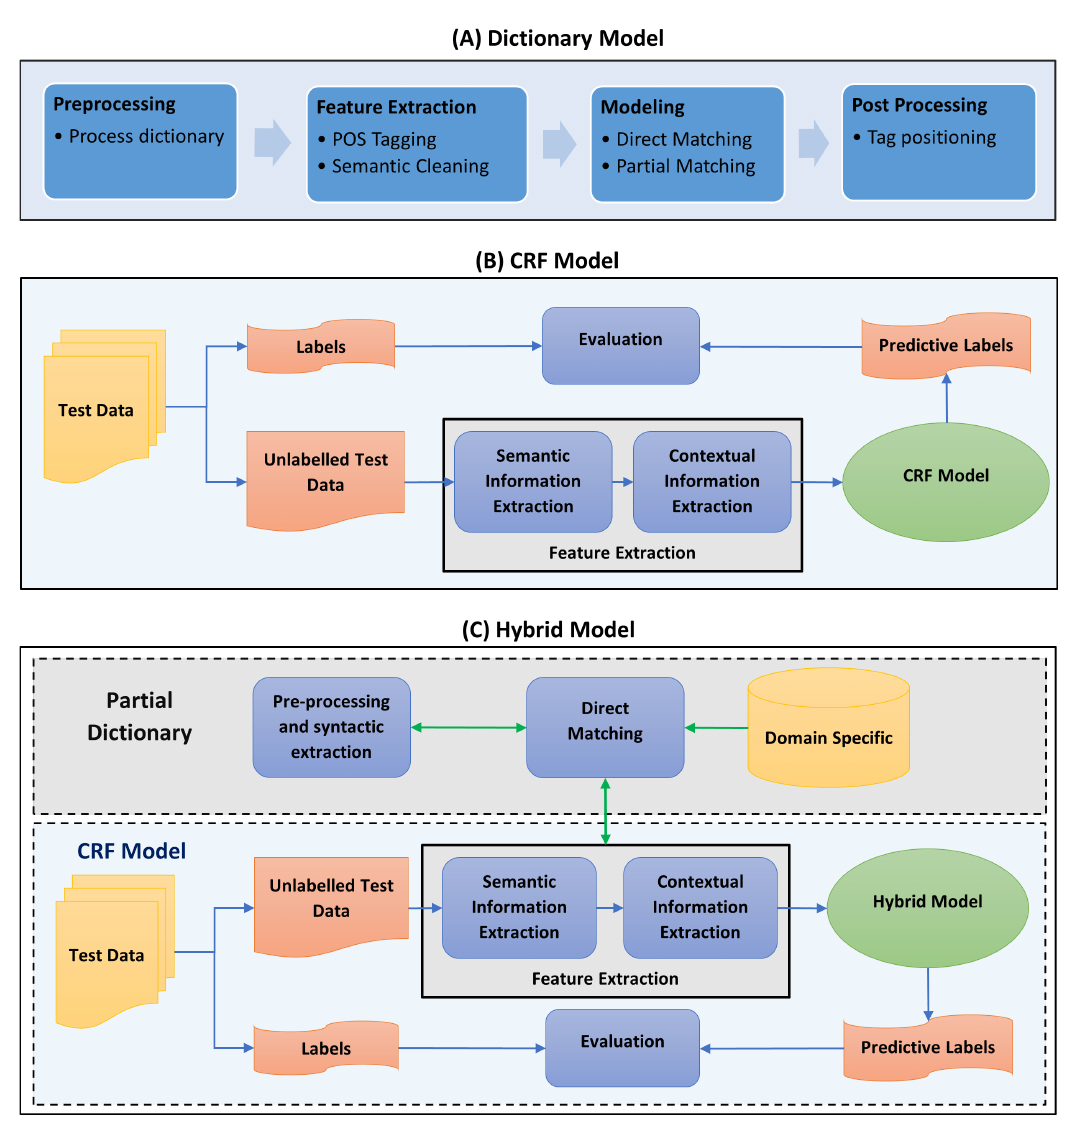
Figure 3. Overview of the architecture of the ( A ) dictionary model, ( B ) CRF model and ( C ) the Hybrid model (FooDCoNER) that uses a partial dictionary model as part of the feature extraction